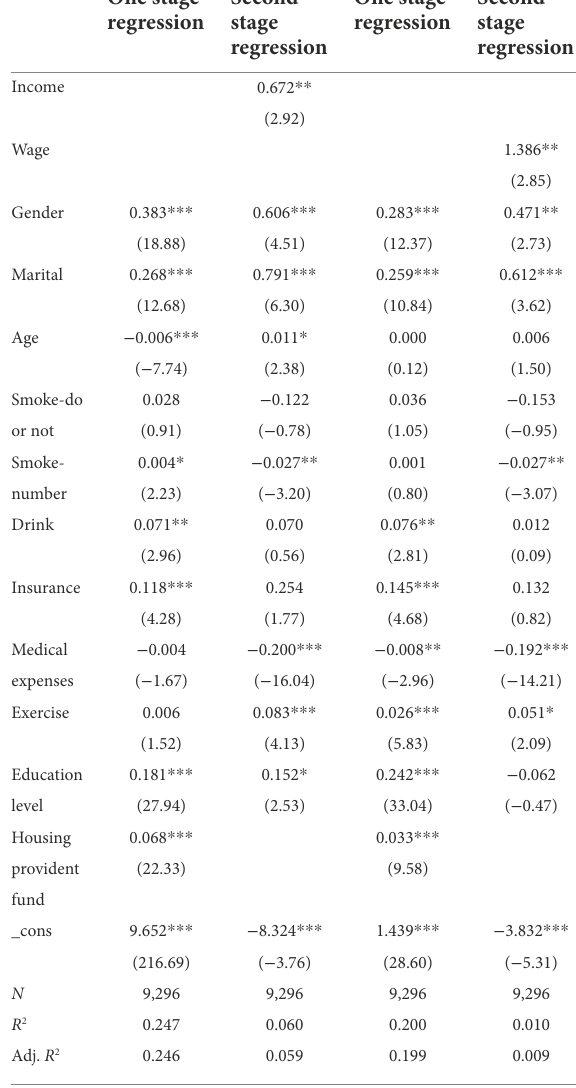
TABLE 4 Two-stage least squares regression